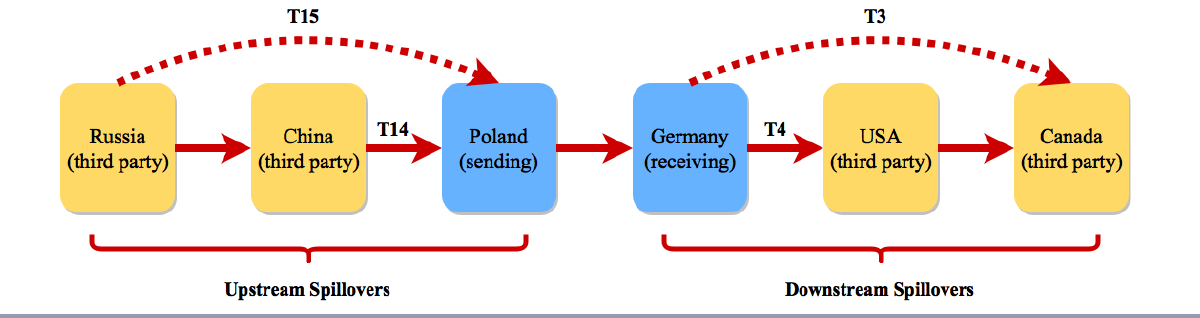
Fig. 2 . Spillover effects in international telecoupled trade. Trade between countries to the right of the figure induce production and consumption of resources in countries to the left of the figure. Dotted arrows indicate exports of intermediate products, and whole solid arrows indicate exports of final products. Letters and numbers are referred to in the Methods